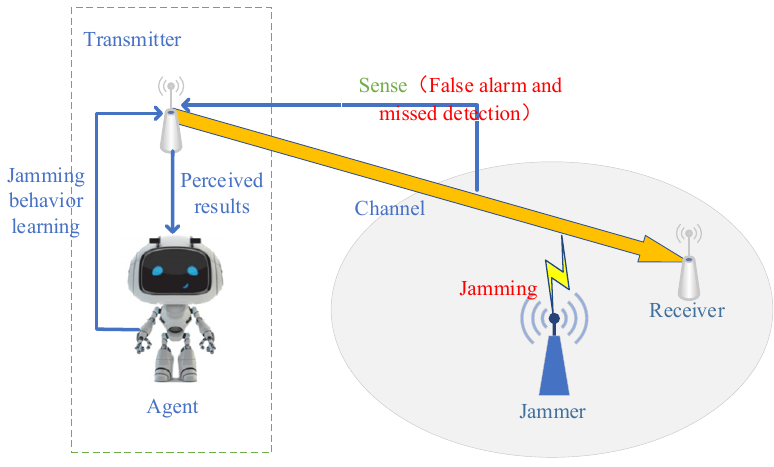
Figure 1. Communication system model.